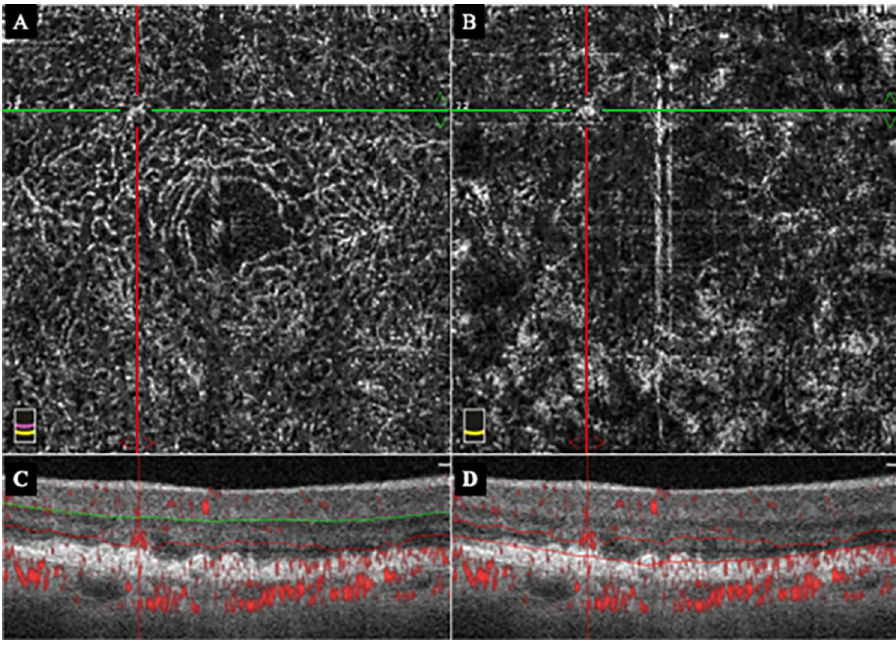
Fig 5. OCTA and OCT images at 3 months before the onset of type 3 MNV of the right eye in the same case shown in Fig 4. A: Prior en face OCTA image of the DCP segment showing abnormal blood pattern in the superotemporal area of the macula bordered at the intersection of the horizontal (green) and vertical (red) lines. B: Prior en face OCTA image of the OR segment showing abnormal blood pattern in the superior-temporal area of the macula. C: B scan OCTA image of the right eye overlayed with blood information shows the abnormal blood pattern in the DCP segment. D: B scan OCTA image overlayed with blood information also shows the abnormal blood pattern in the OR